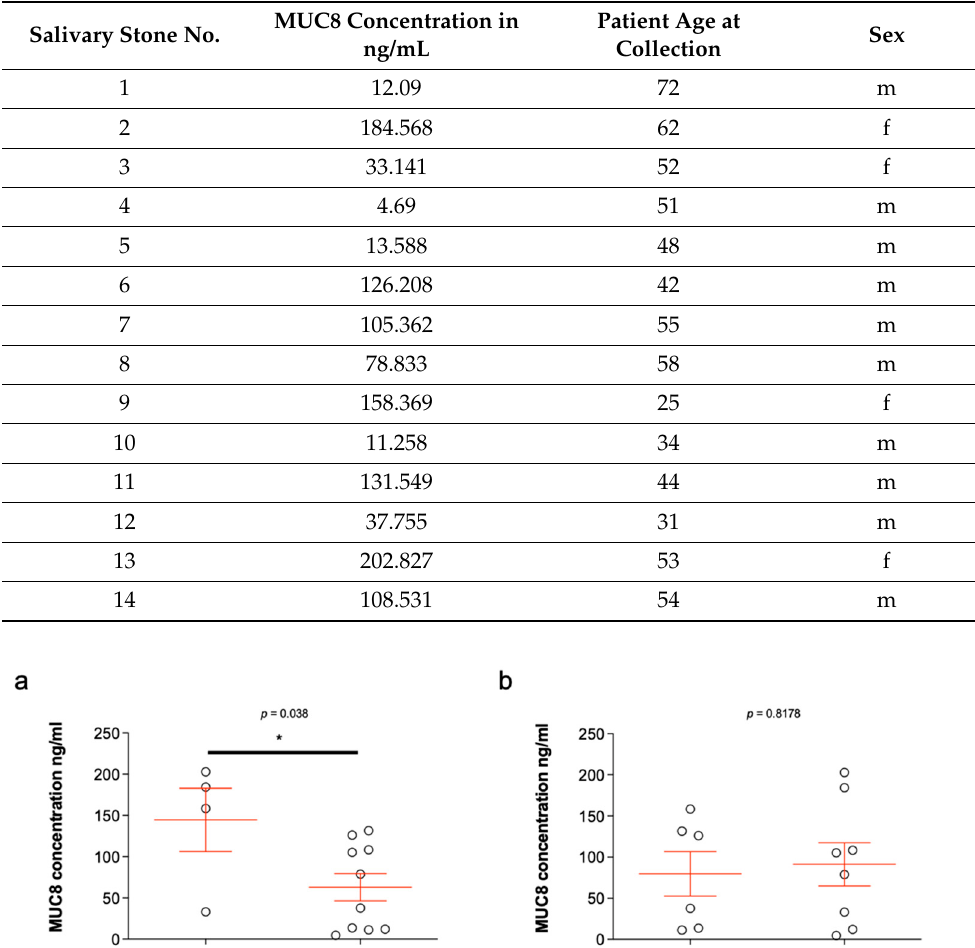
Table 1. Overview of MUC8 concentrations in salivary stones (m = males; f = females).